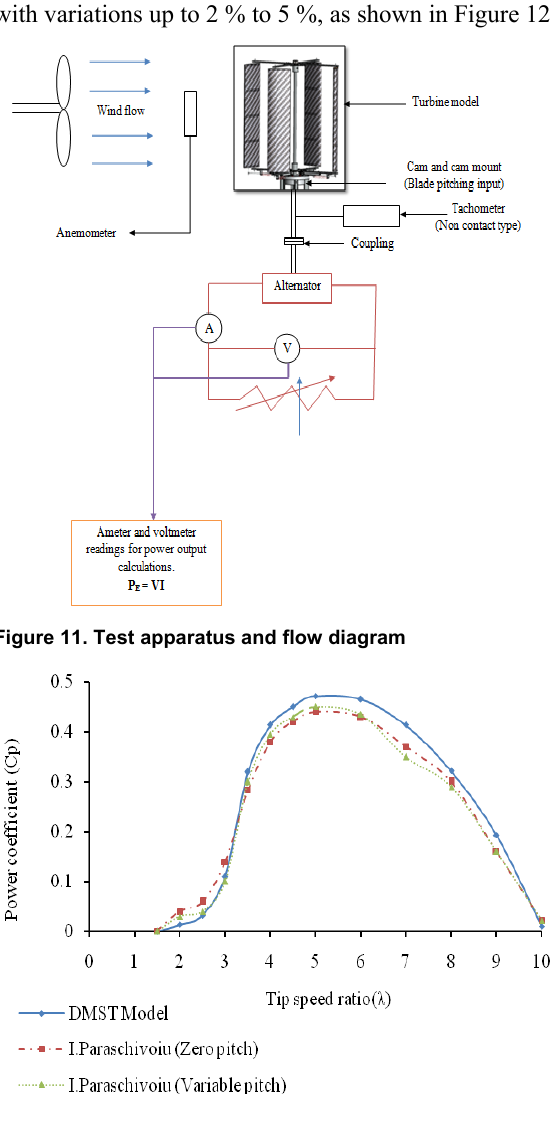
Figure 12. Turbine result